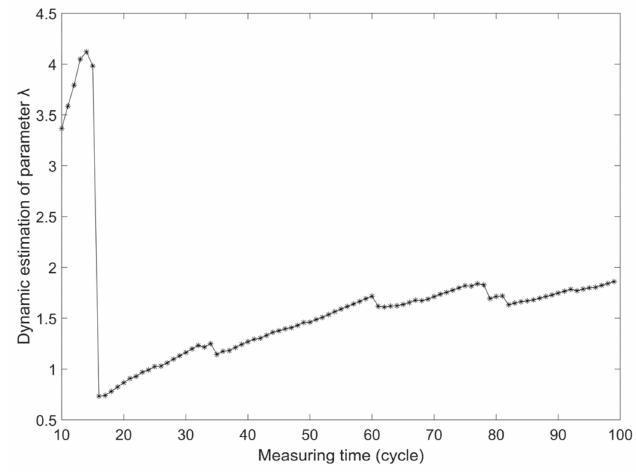
Figure 3. Dynamic estimation of parameter λ .